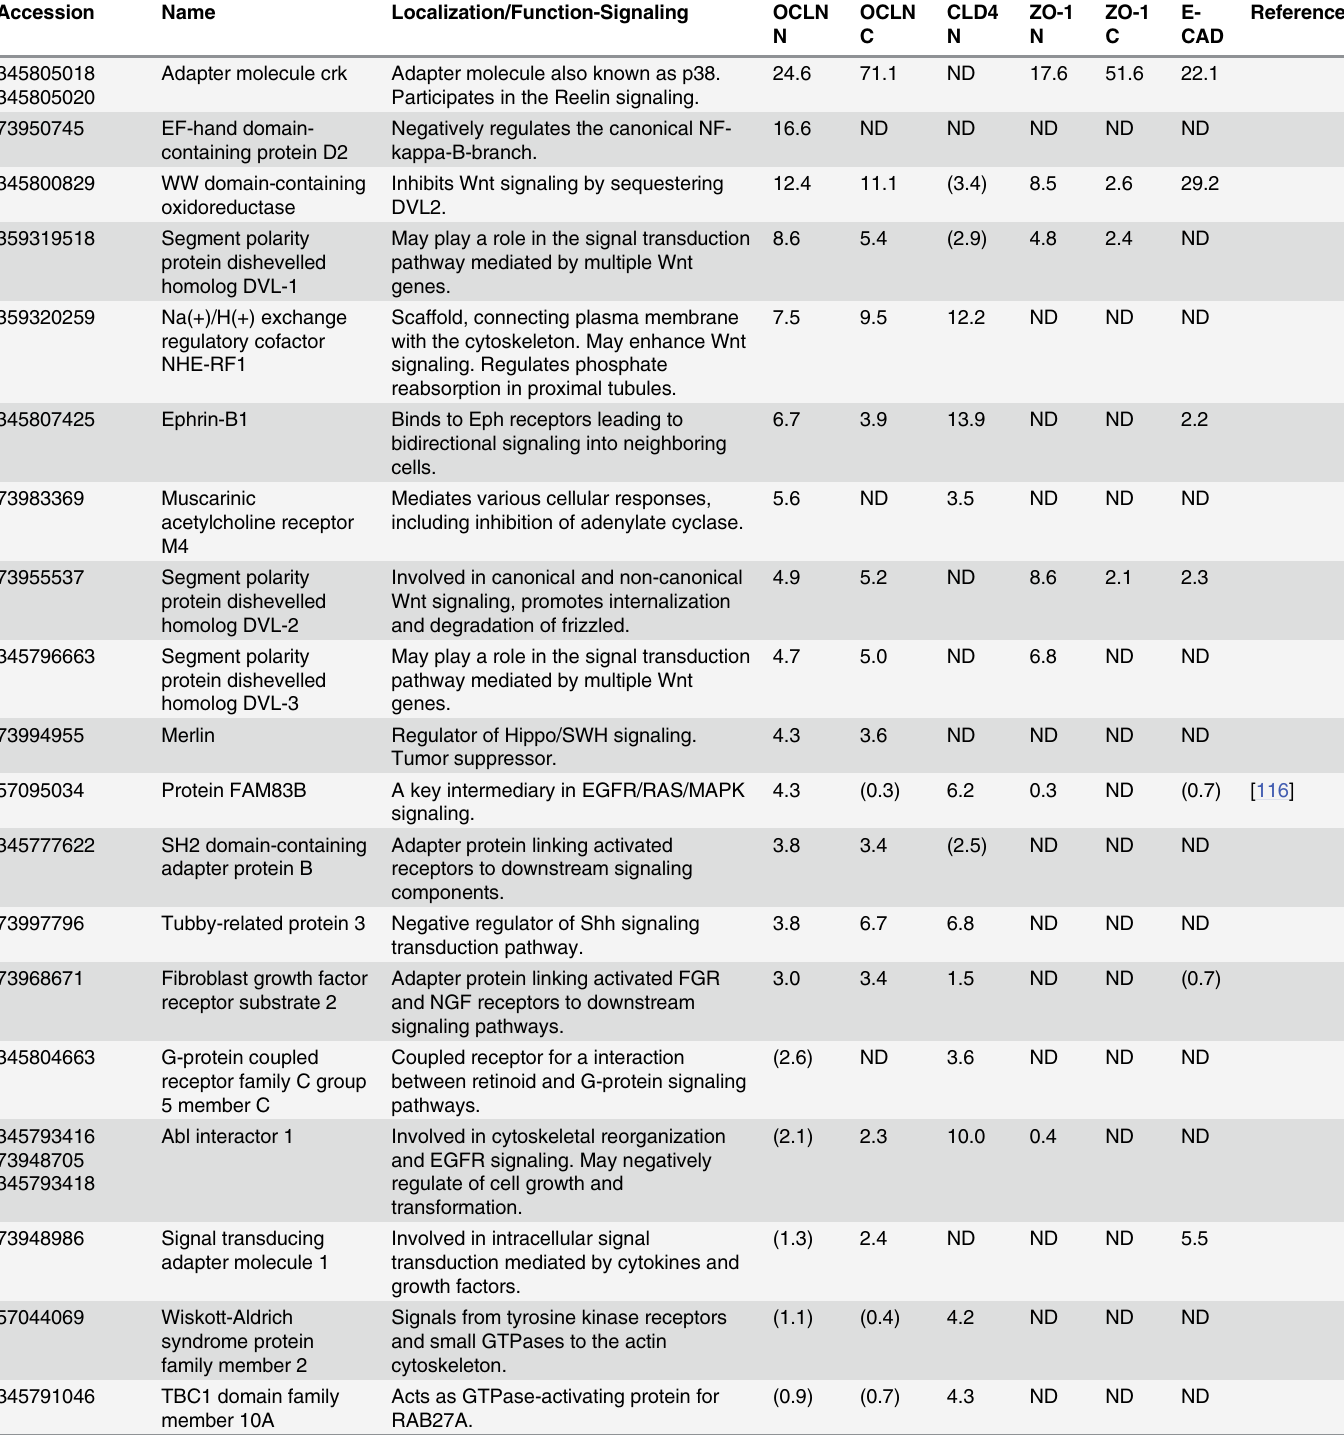
Table 2. Enriched signaling proteins tagged by biotin ligase fused to occludin and